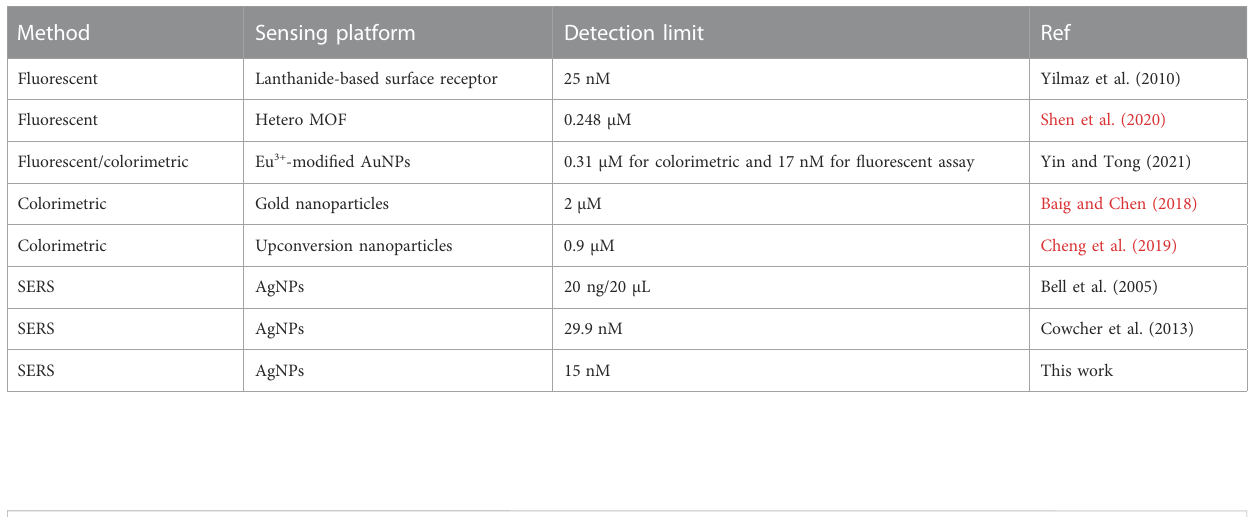
TABLE 1 Comparison of different methods for DPA detection.